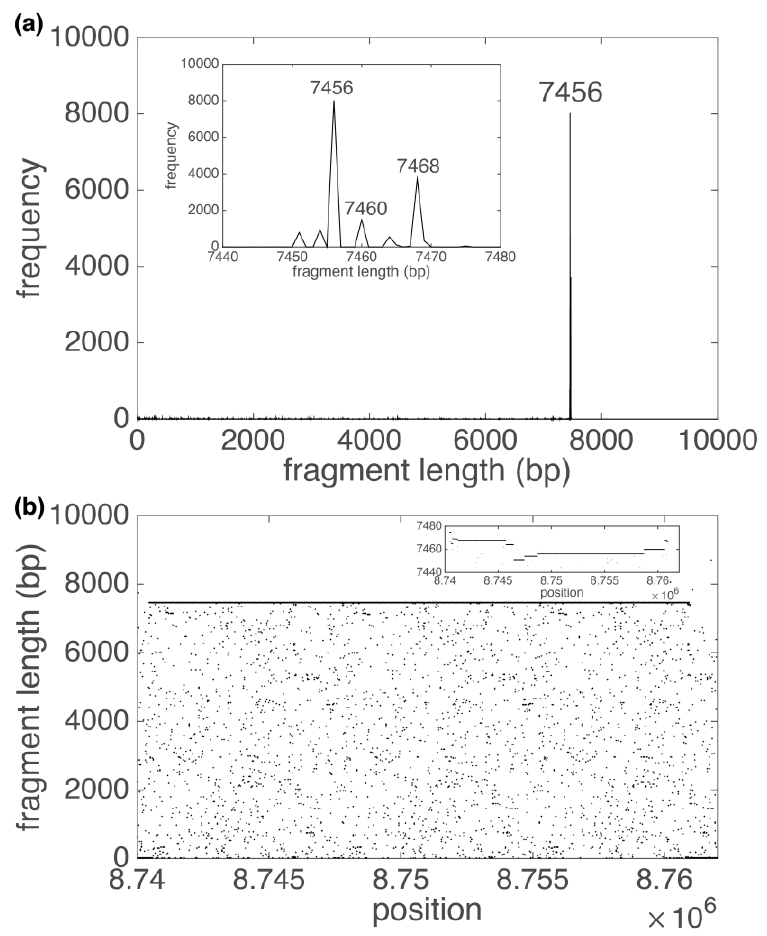
Figure 4. GRM diagram ( a ) and Fragment diagram ( b ) for 7456 bp TR subarray in human chromosome 19 (Supplementary Table S1, repeat No. 538). ( a ) The pronounced GRM peak at 7456 bp corresponds to basic repeat unit of 7456 bp. Insert gives magnified presentation of weak peaks around 7456 bp, which are sizably screened by a 7456 bp peak. ( b ) Each dot in the Fragment diagram corresponds to the fragment length (component 𝑎 3𝑖 of vector 𝒂 𝑖 ) at that position (component 𝑎 1𝑖 of vec- tor 𝒂 𝑖 ) . Insert gives magnified presentation of points around 7456 bp, which are consequence of nucleotide mutation in TR copies. In the Fragment diagram, most points are located around y = 7456 bp, which corresponds to 7456 bp peak in the GRM diagram. The other points in the Fragment dia- gram create a small noise, which is visible in the GRM diagram as tiny peaks.